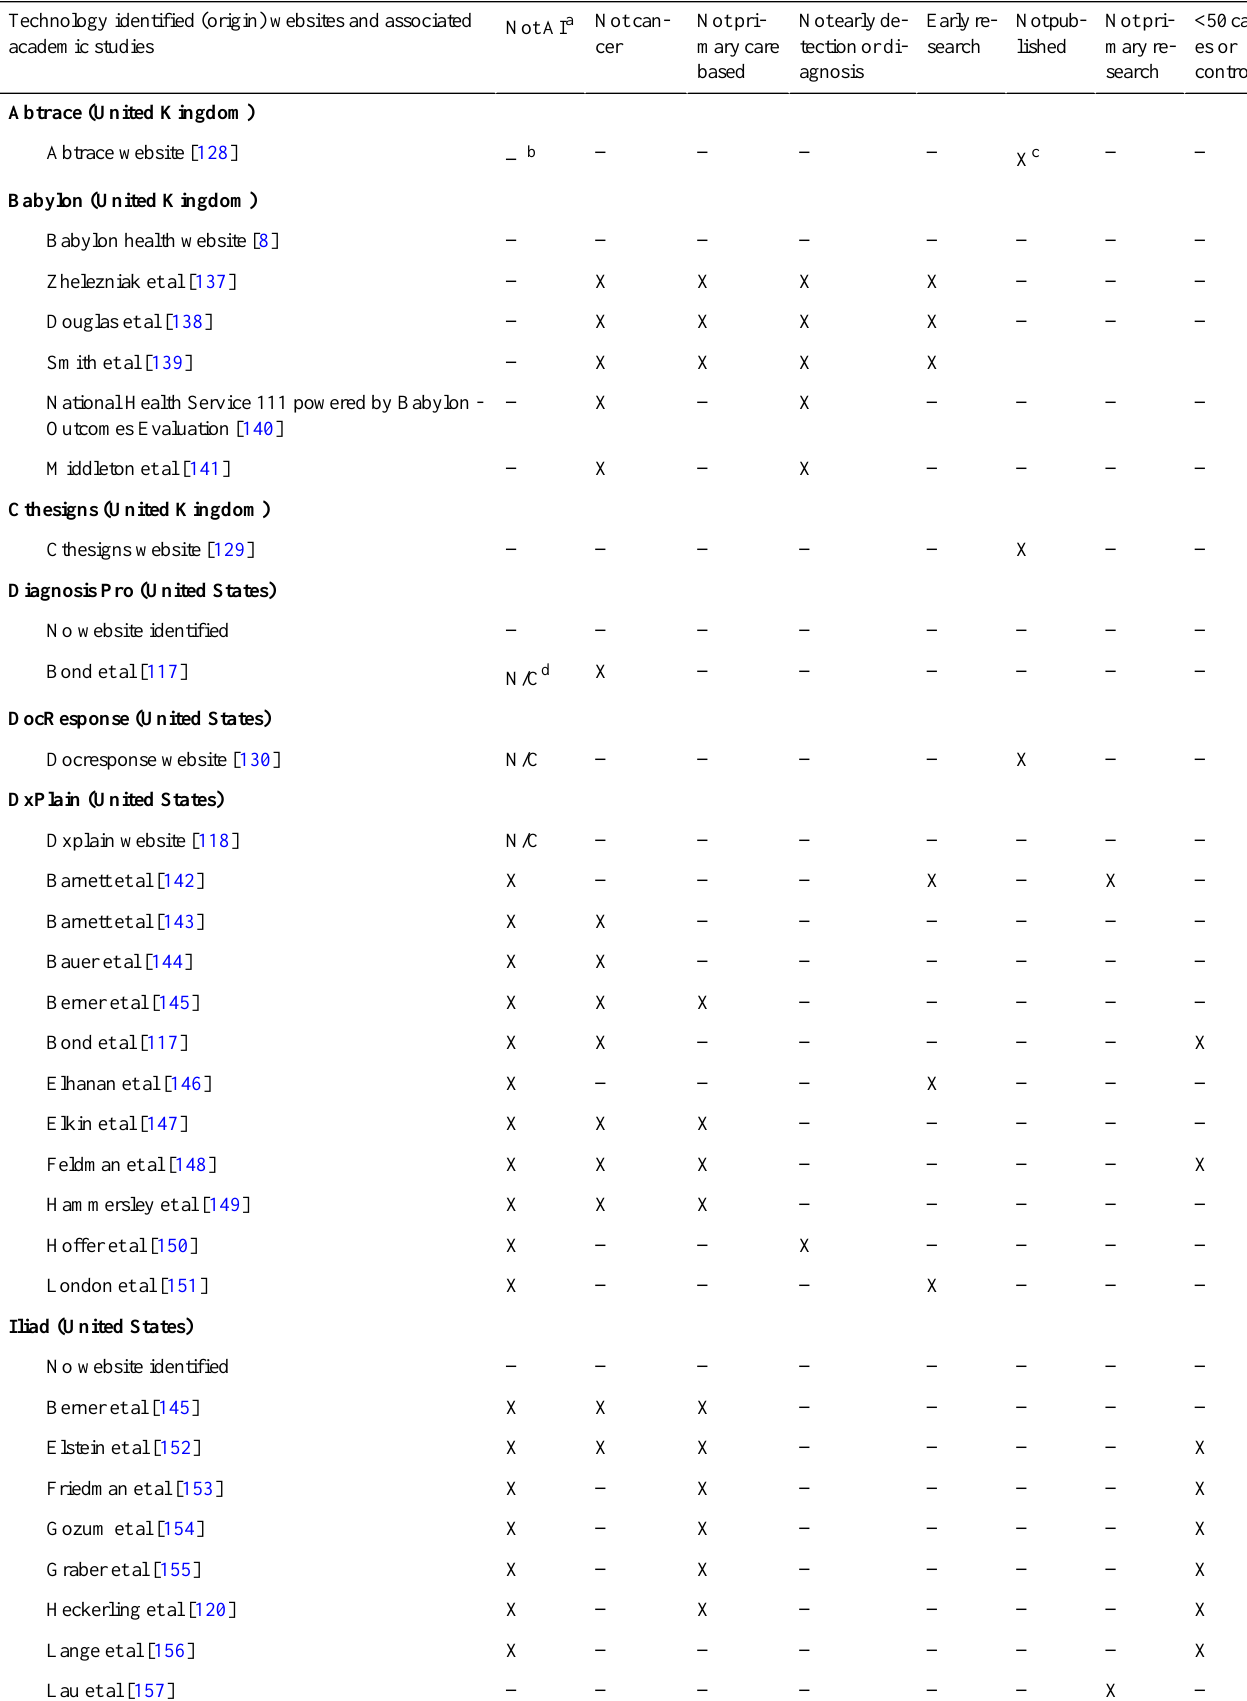
Table 6. Summarizing scoping review of commercial artificial intelligence